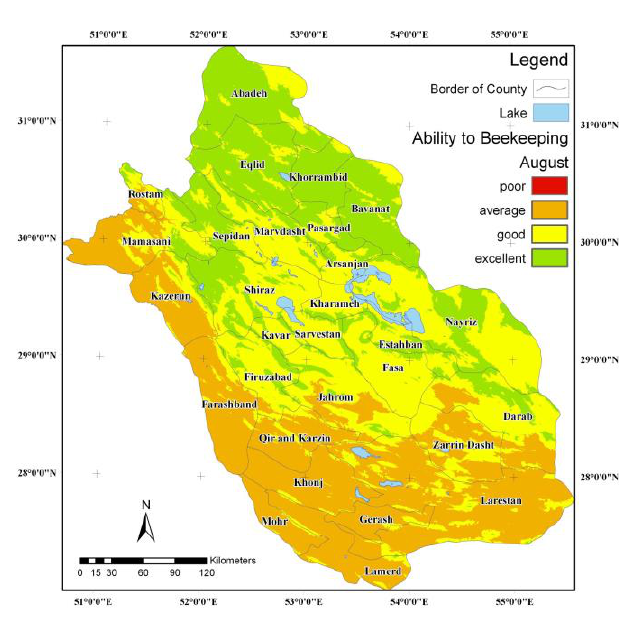
Fig. 5. Suitability of climate conditions for beekeeping in August.